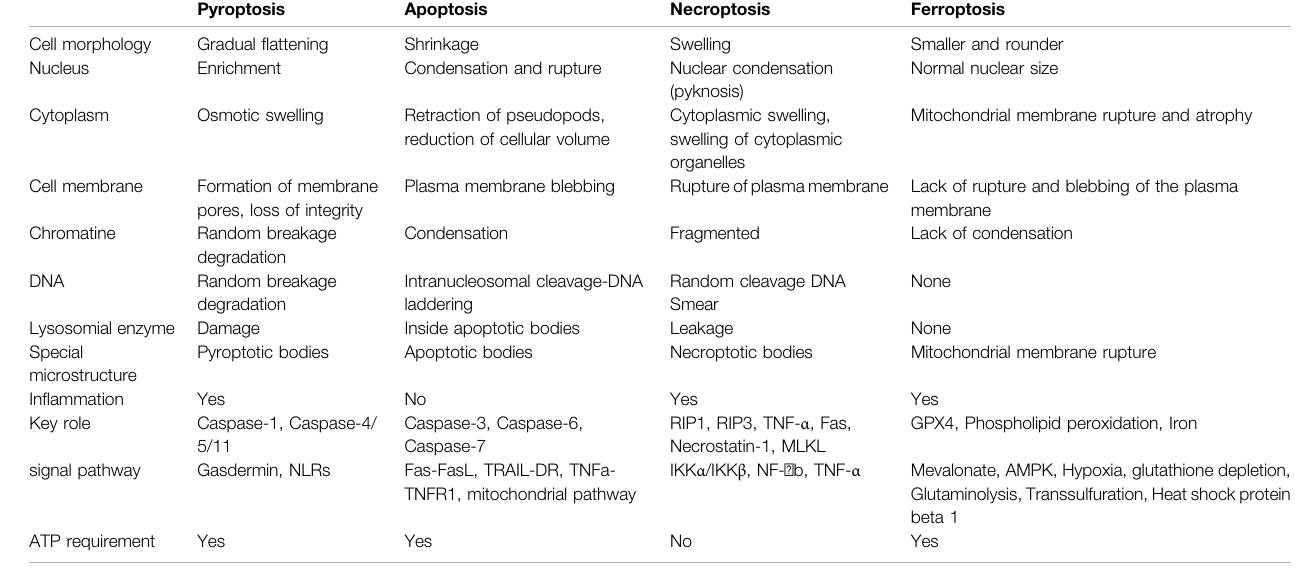
TABLE 2 | The main morphological, biochemical, and signaling pathways involved in the regulation of pyroptosis, apoptosis, necroptosis, and ferroptosis (Kerr et al., 1972; Xu and Shi, 2007; Charlier et al., 2016; Newton and Manning, 2016; Xie et al., 2016; Yang and Stockwell, 2016; Zargarian et al., 2017; Jiang and Stockwell, 2021). Cell Components/